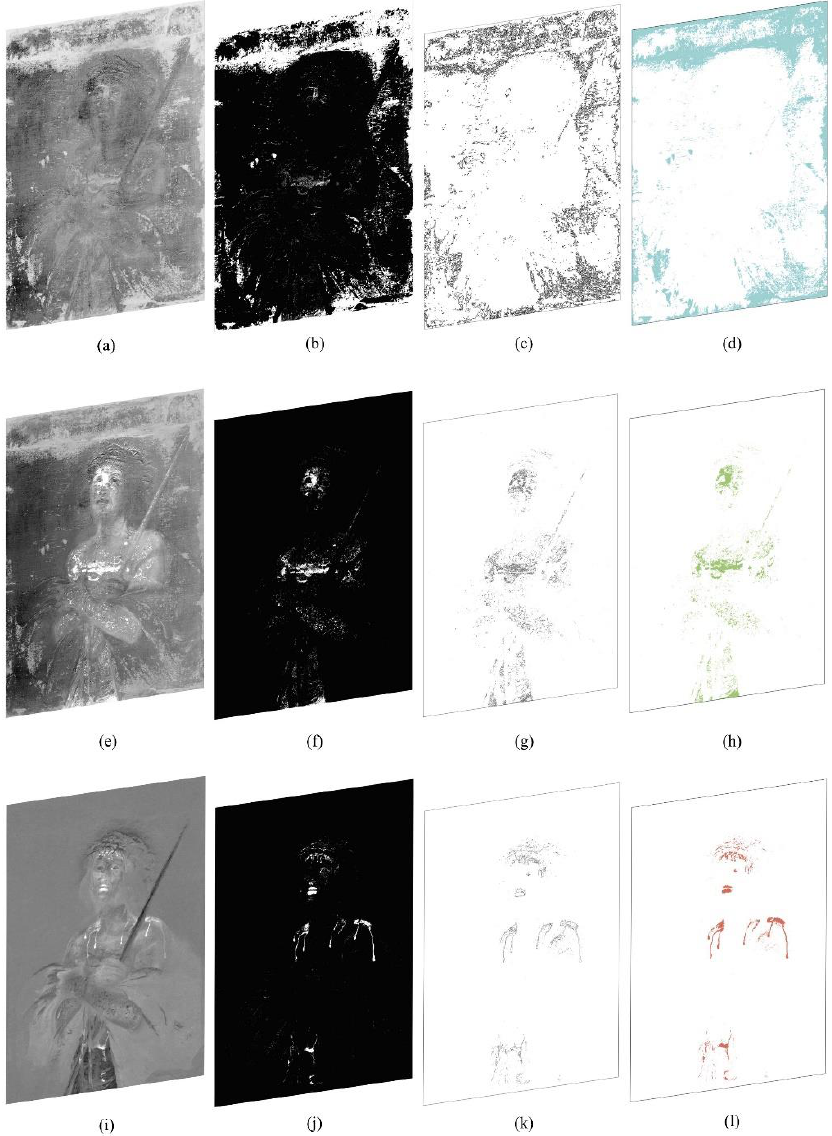
Figure 4. Phase I stages 3–4: ( a , e , i ) Images processed from the previous stage (in Figure 3) and chosen to identify regions of interest (ROIs); ( b , f , j ) Corresponding binarized versions; ( c , g , k ) Image polygonization, raster to vector conversion. Phase II stage 5: ( d , h , l ) Characterization of the extracted polygons.